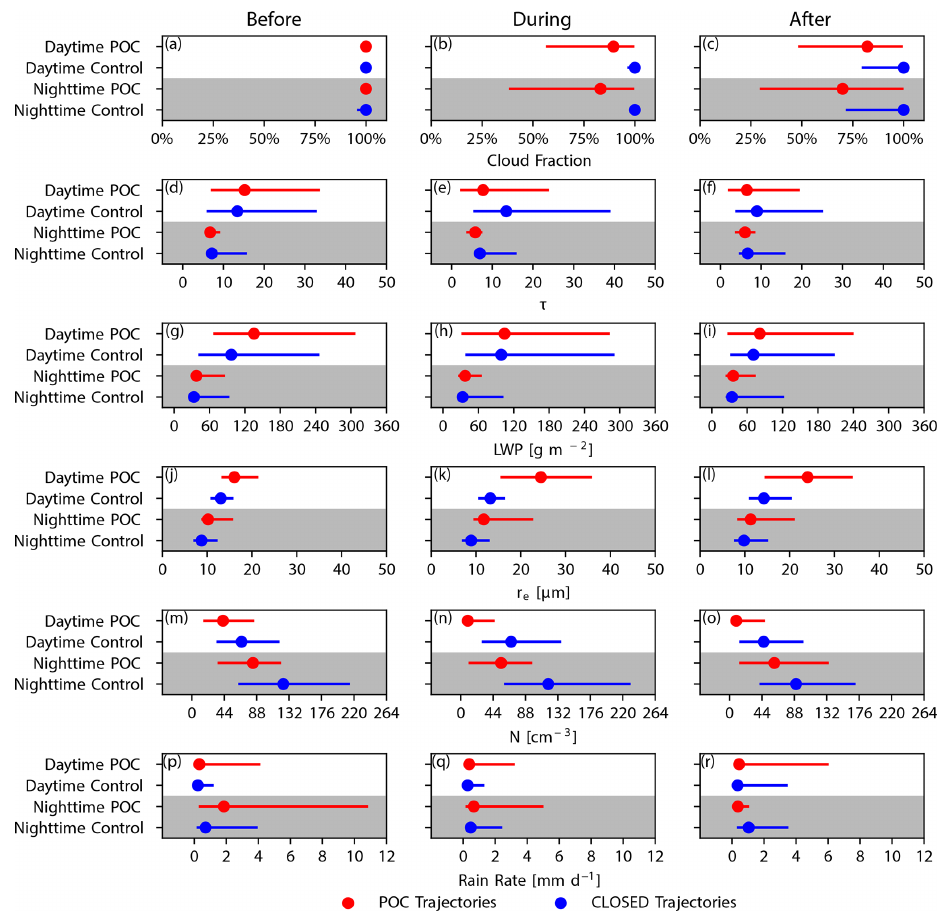
Figure 14. Daytime statistics for cloud fraction (a, b, c) , cloud optical depth (d, e, f) , liquid water path (g, h, i) , cloud-top effective radius (j, k, l) , cloud drop number concentration (m, n, o) , and Advanced Microwave Scanning Radiometer 2 rain rate (p, q, r) are shown in the upper (white) half of each panel, while the nighttime statistics are shown in the gray (lower) half of each panel. Red values represent the pocket of open-cell stratocumulus (POC) trajectories, while the blue values represent the comparison (CLOSED) trajectories. The colored dots represent the median of each distribution, and the horizontal lines represent the spread between the 10th and 90th percentiles.